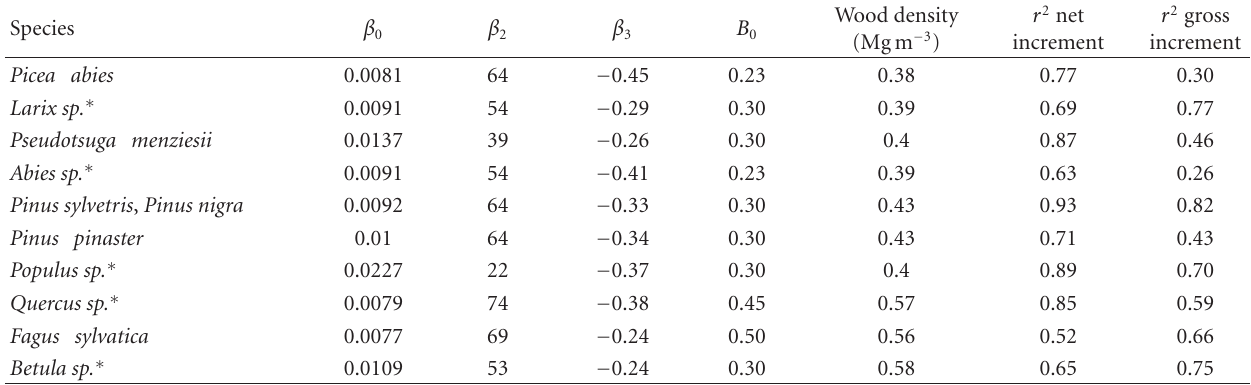
Table 2: Species-specific parameters and growth submodel fitting statistics.